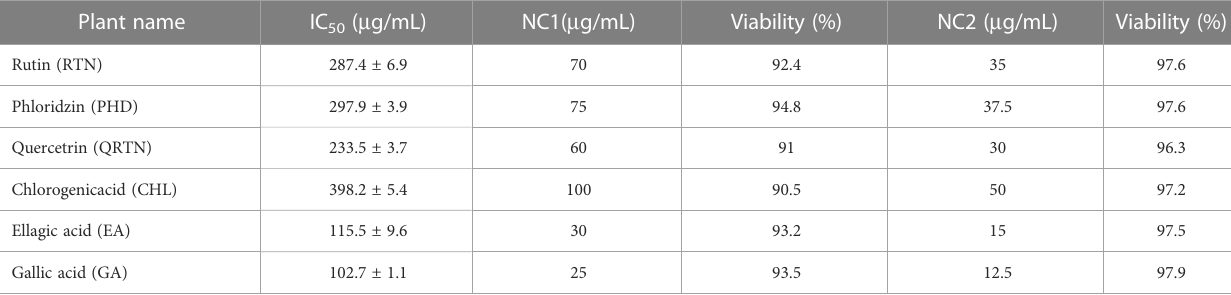
TABLE 4 The IC 50 of six herbal compounds and their non-cytotoxic concentrations (NC1 and NC2). Plant name